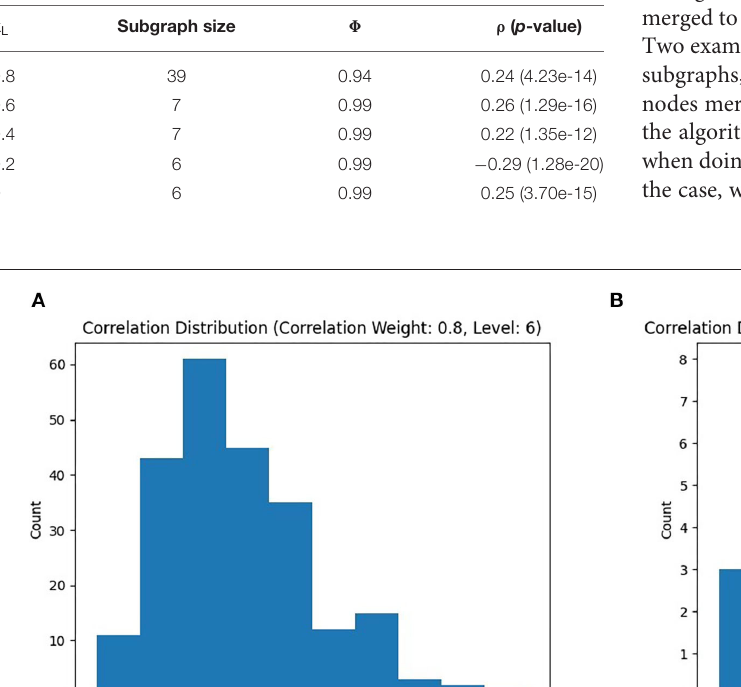
Frontiers in Big Data |